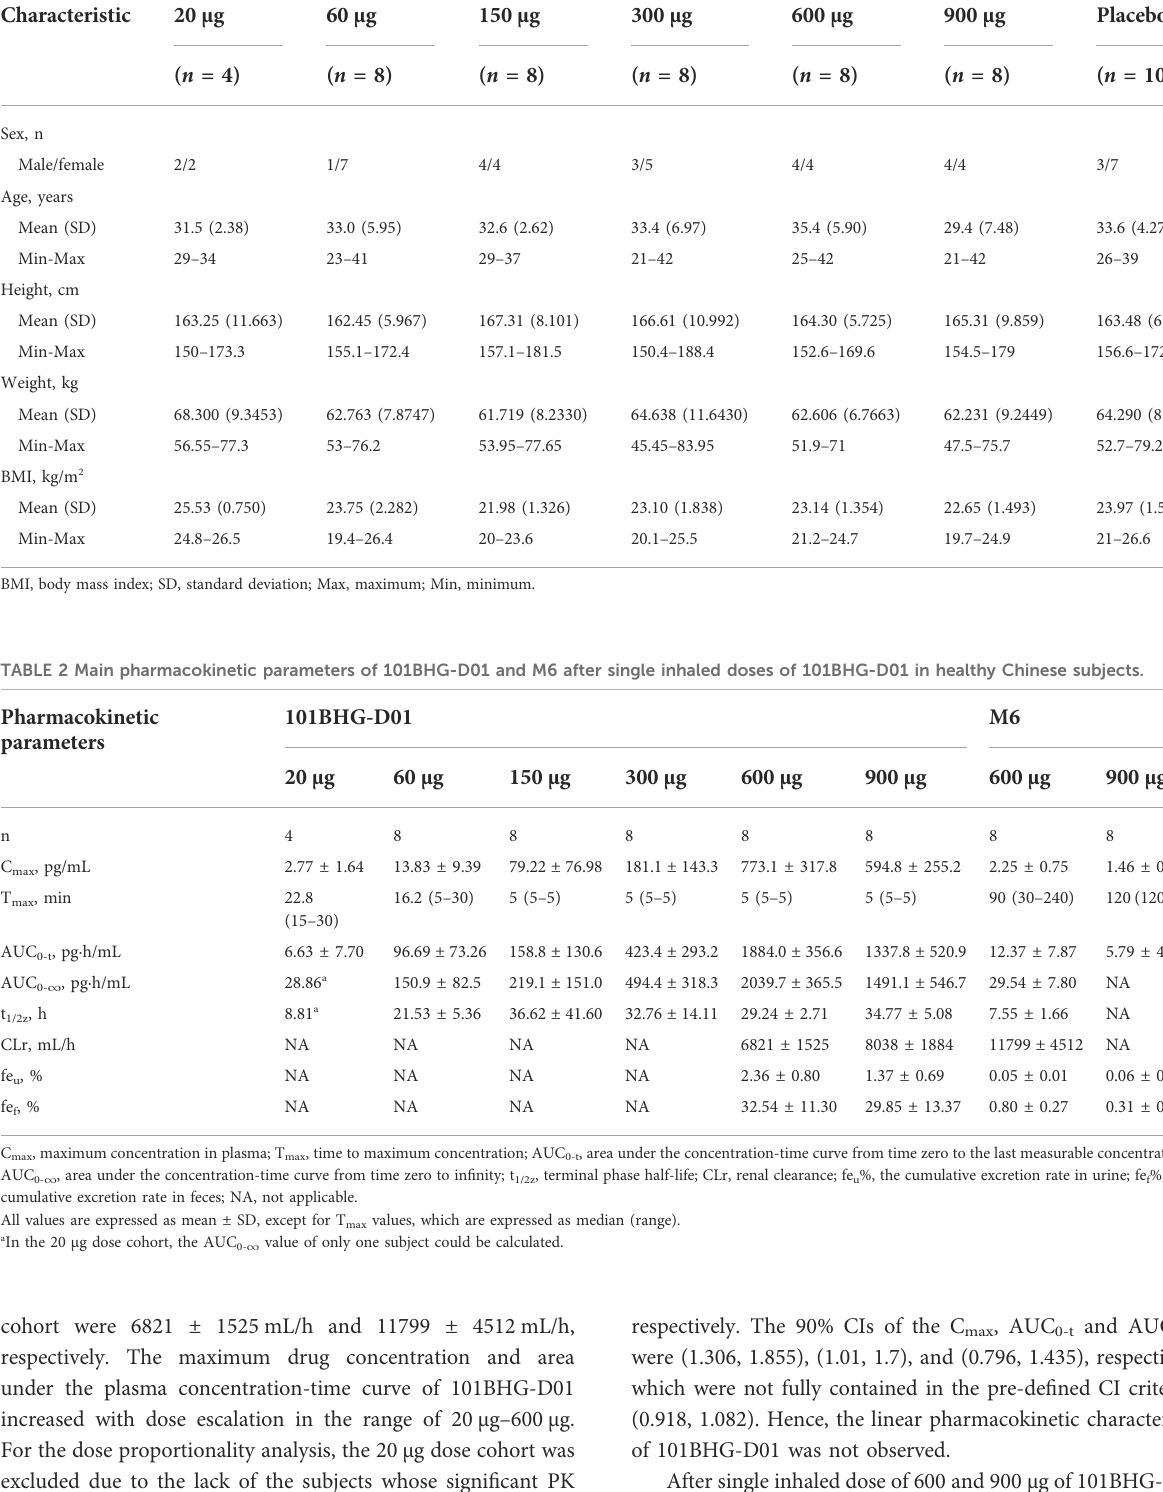
TABLE 1 Baseline demographic data of the study population. Characteristic